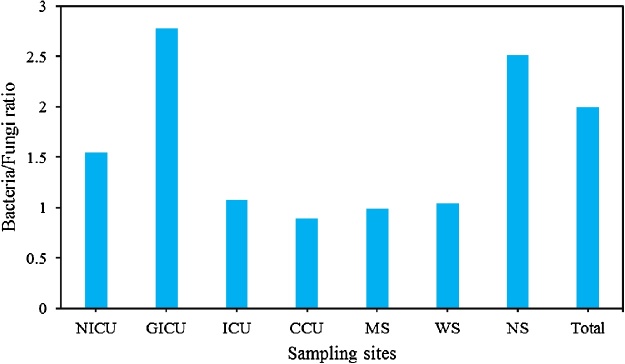
Bacterial /fungal bioaerosol concentration ratios in all sampling sites during the study.